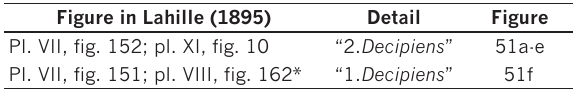
Table 21. Specimens of Voluta tuberculata decipiens figured by Lahille (1895) with the detail of the inscriptions on their shells.